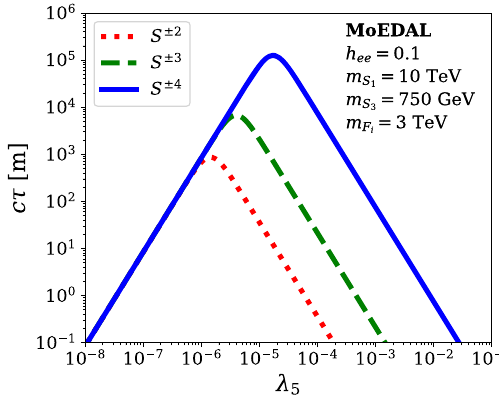
be 3 and 10 TeV in the left and right plots, respectively. The other parameters are fixed as h ee = 0 . 1, m S ( i = 1 , 2 , is taken to 1